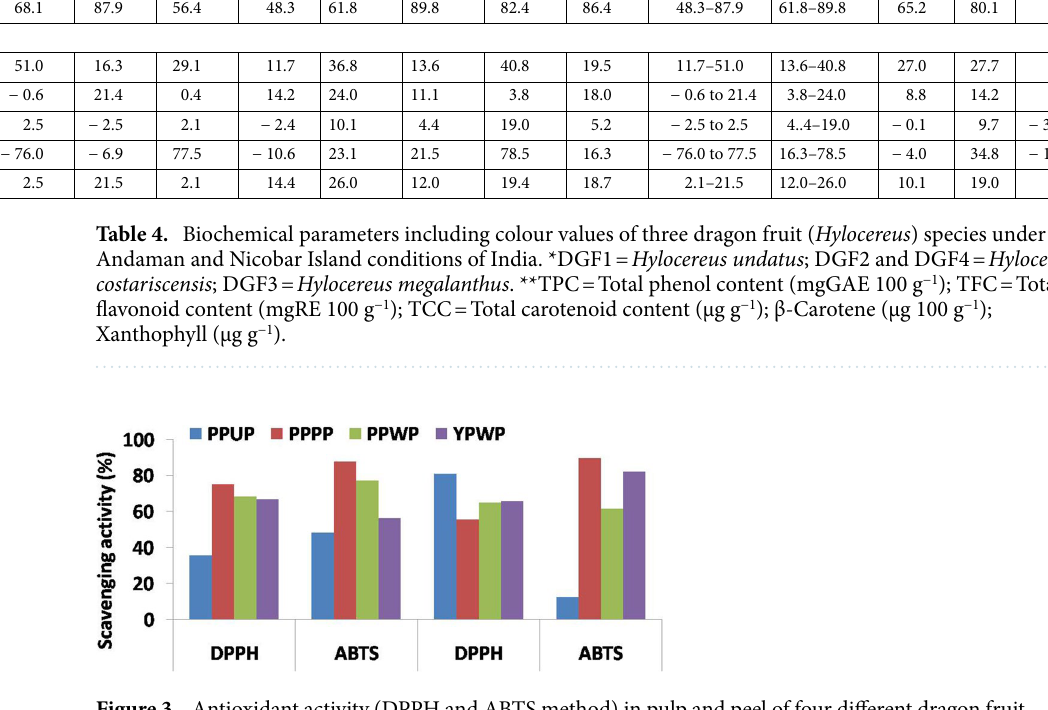
Figure 3. Antioxidant activity (DPPH and ABTS method) in pulp and peel of four different dragon fruit accessions [PPUP (pink peel with dark purple pulp) = DGF4; PPPP (pinkish red peel with pink pulp) = DGF2; PPWP (pinkish green peel with white pulp) = DGF1; YPWP (yellow peel with white pulp) = DGF3]; * DGF1 = Hylocereus undatus ; DGF2 & DGF4 = Hylocereus costariscensis ; DGF3 = Hylocereus megalanthus